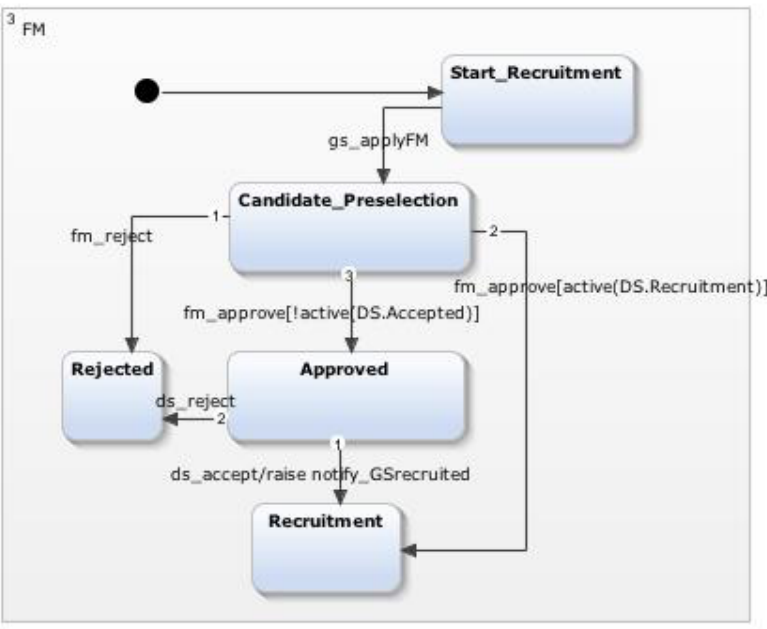
Figure 3. Statechart model of behavior of the Faculty Member (FM) within the operational PhD recruitment process defined by the University